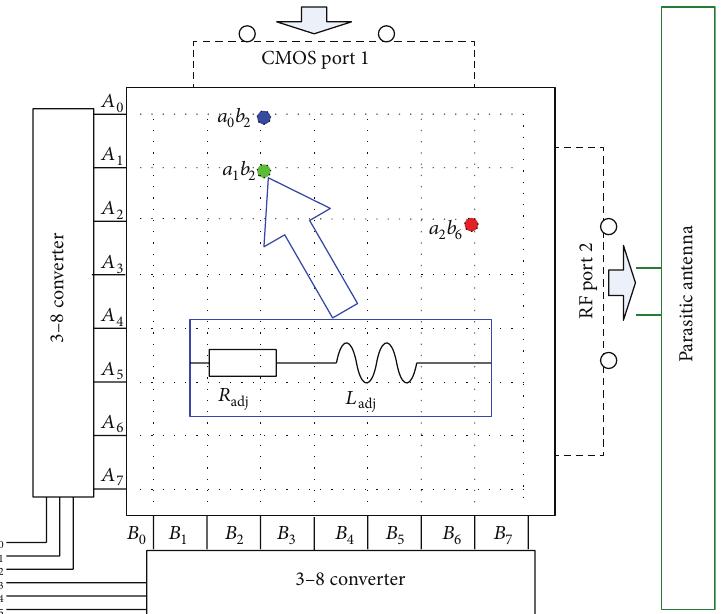
Figure 7: Topology of the proposed digitally controlled adjusting network.